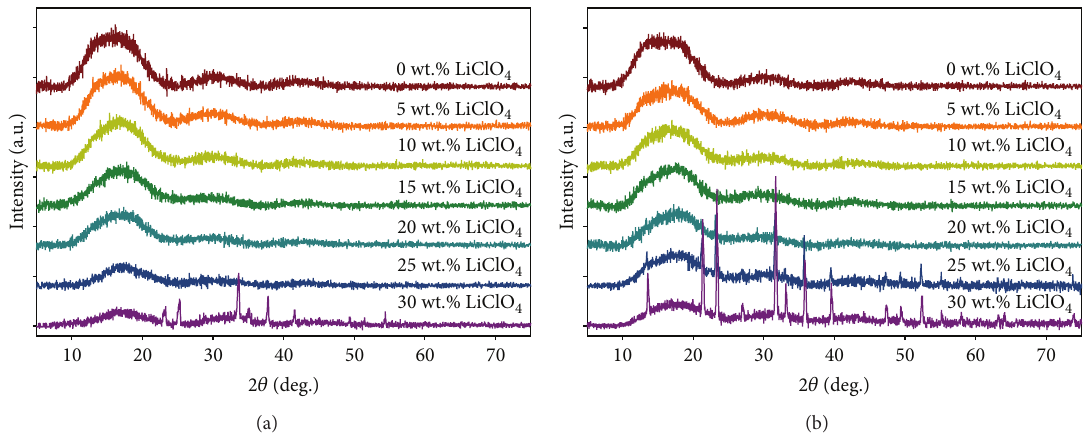
Figure 1: X-ray diffraction patterns: (a) [MG49- 𝑥 wt.% LiClO 4 ]:[8.0 wt.% HNO 3 -THF/TiO 2 -SiO 2 ] and (b) [MG49- 𝑥 wt.% LiClO 4 ]:[8.0 wt.% ClHNO 2 -THF/TiO 2 -SiO 2 ] polymer